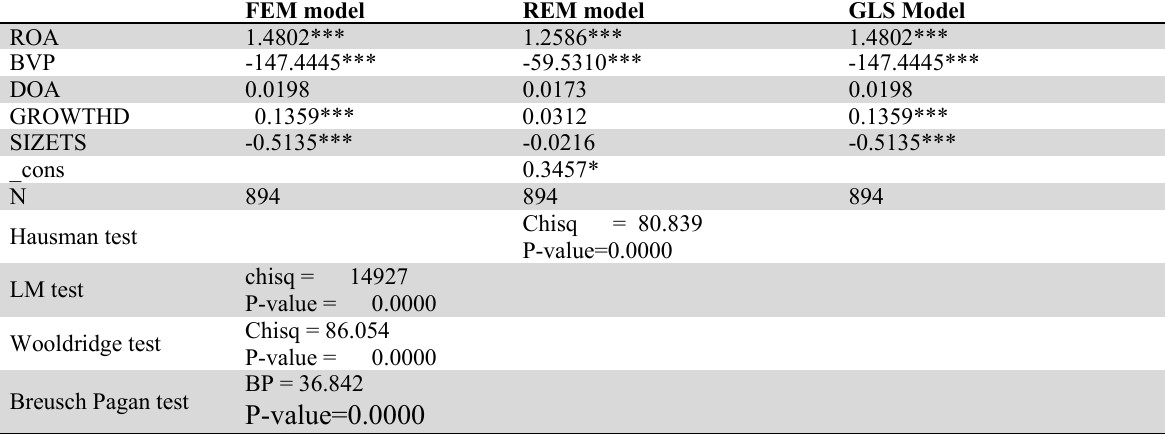
Regression with the profitability variable of